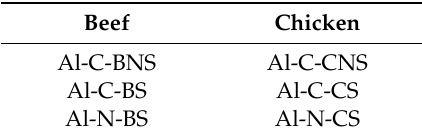
Table 2. Aluminum samples taken from the wraps used for baking beef and chicken and analyzed by SEM: Al-C-BNS: Al contact beef, no seasoning; Al-C-BS: Al contact beef, with seasoning; Al-N-BS: Al no contact beef, with seasoning; Al-C-BNS: Al contact chicken, no seasoning; Al-C-BS: Al contact chicken, with seasoning; Al-N-BS: Al no contact chicken, with seasoning. Beef Chicken Al-C-BNS Al-C-CNS Al-C-BS Al-C-CS Al-N-BS